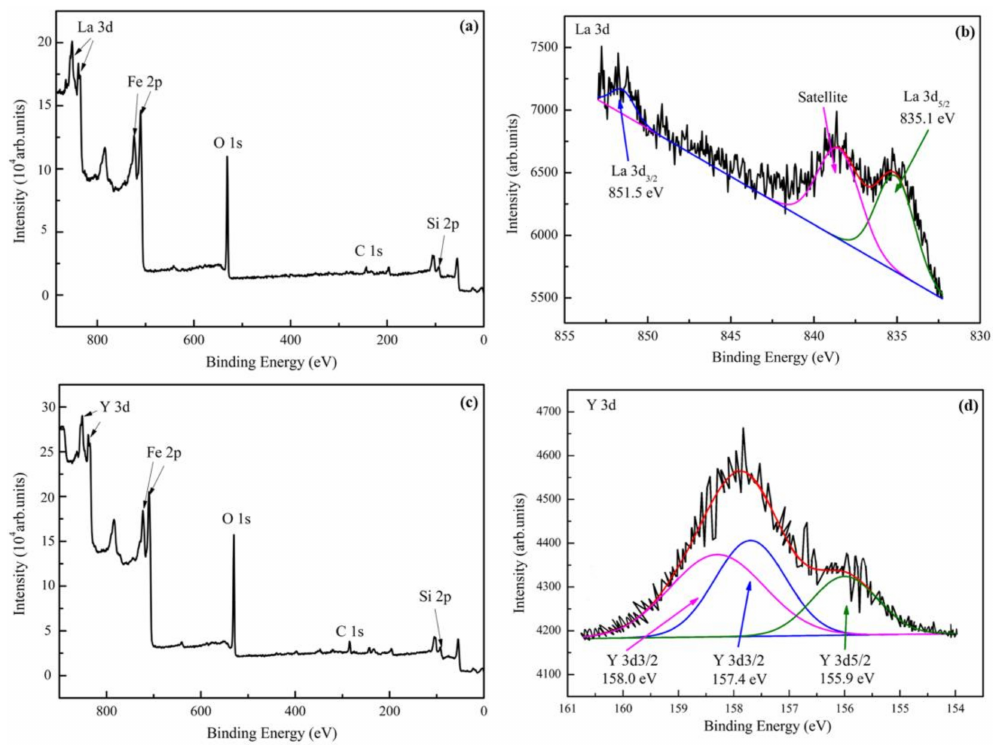
Figure 4. XPS spectra of sample surfaces—( a ) survey spectrum and ( b ) La 3d spectrum of implanted La; ( c ) survey spectrum and ( d ) Y 3d spectrum of implanted Y.